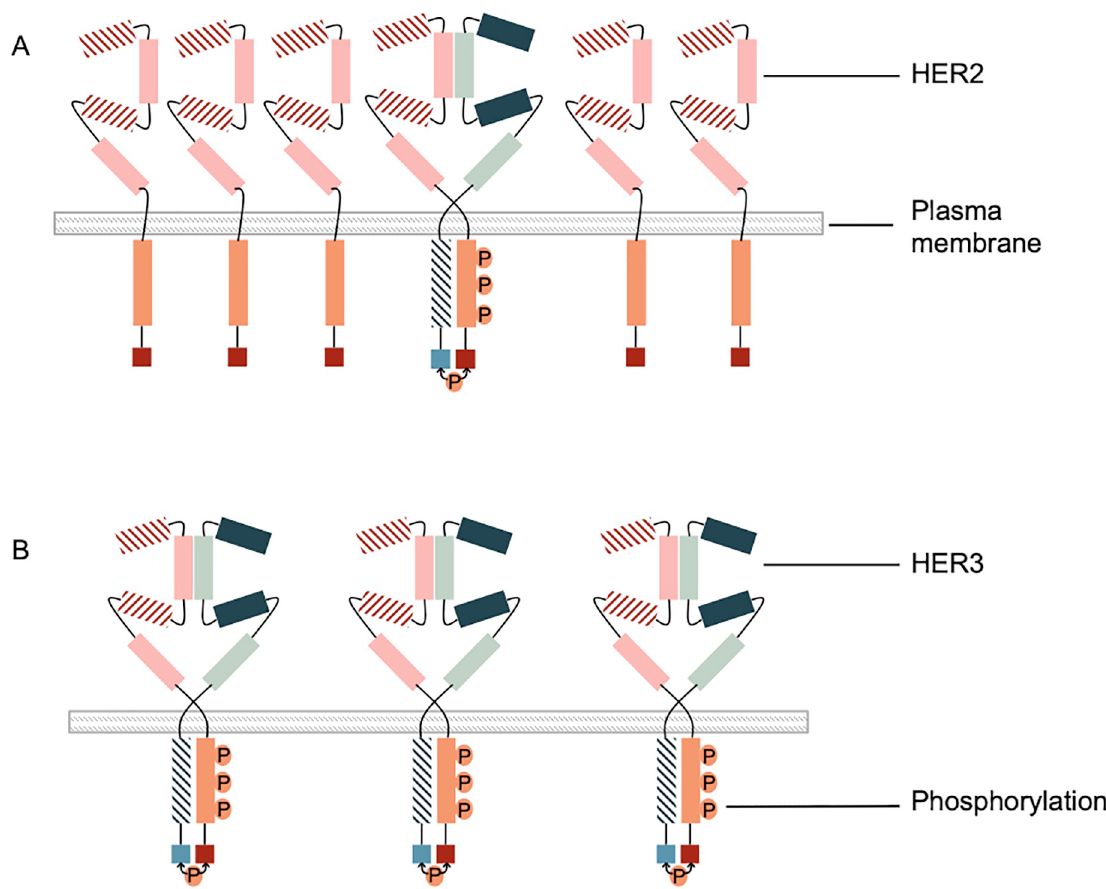
Fig 6. Overexpresion versus overphosphosrylation of HER2. A. Overexpression of HER2 with non-overphosphorylation of HER2 (HER2 +; pHER2-). B. Non-overexpression of HER2 with overphosphorylation of HER2 (HER2-;